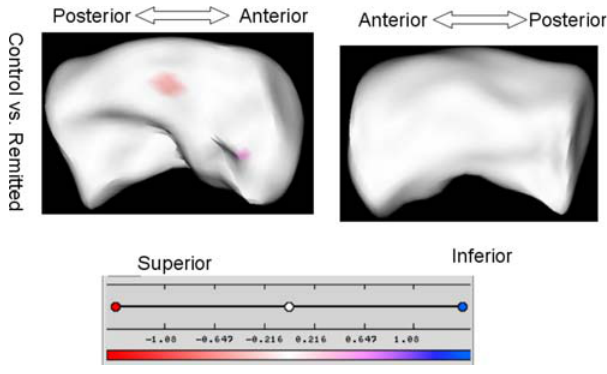
Figure 4. The analysis of left hippocampus: control vs. remitted. The distance maps masked by the significance maps are shown on a representative hippocampus. The scale of color code is illustrated in a color bar and in millimeters.